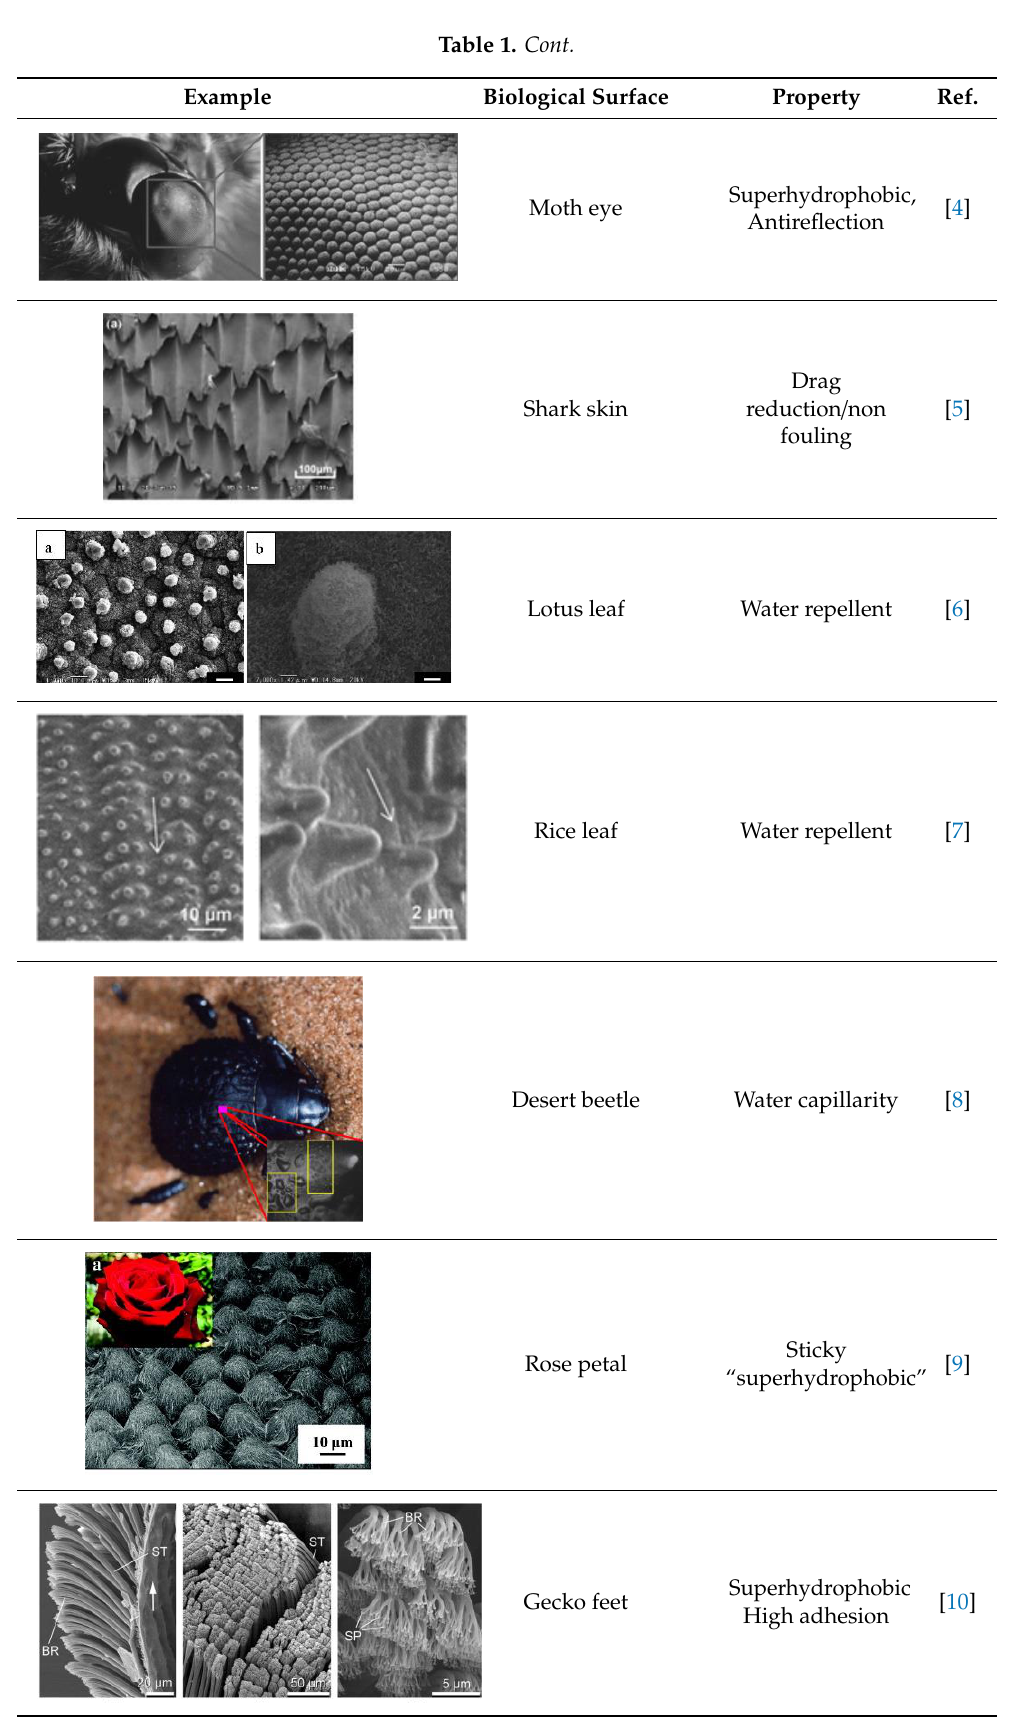
2 of 19 Table 1. Examples of nano-/micro-textured biological surfaces. Example Biological Surface Property Ref.